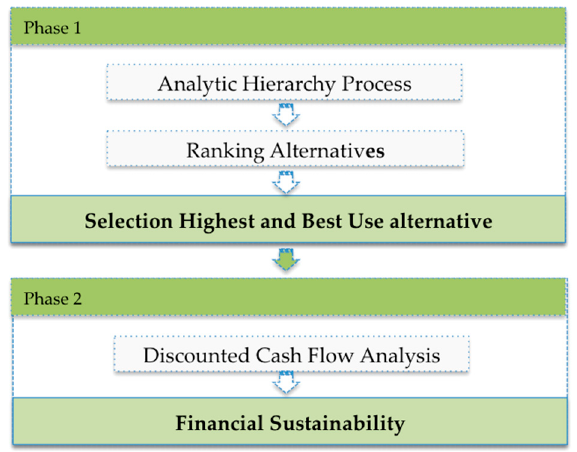
Figure 2. The methodological framework.